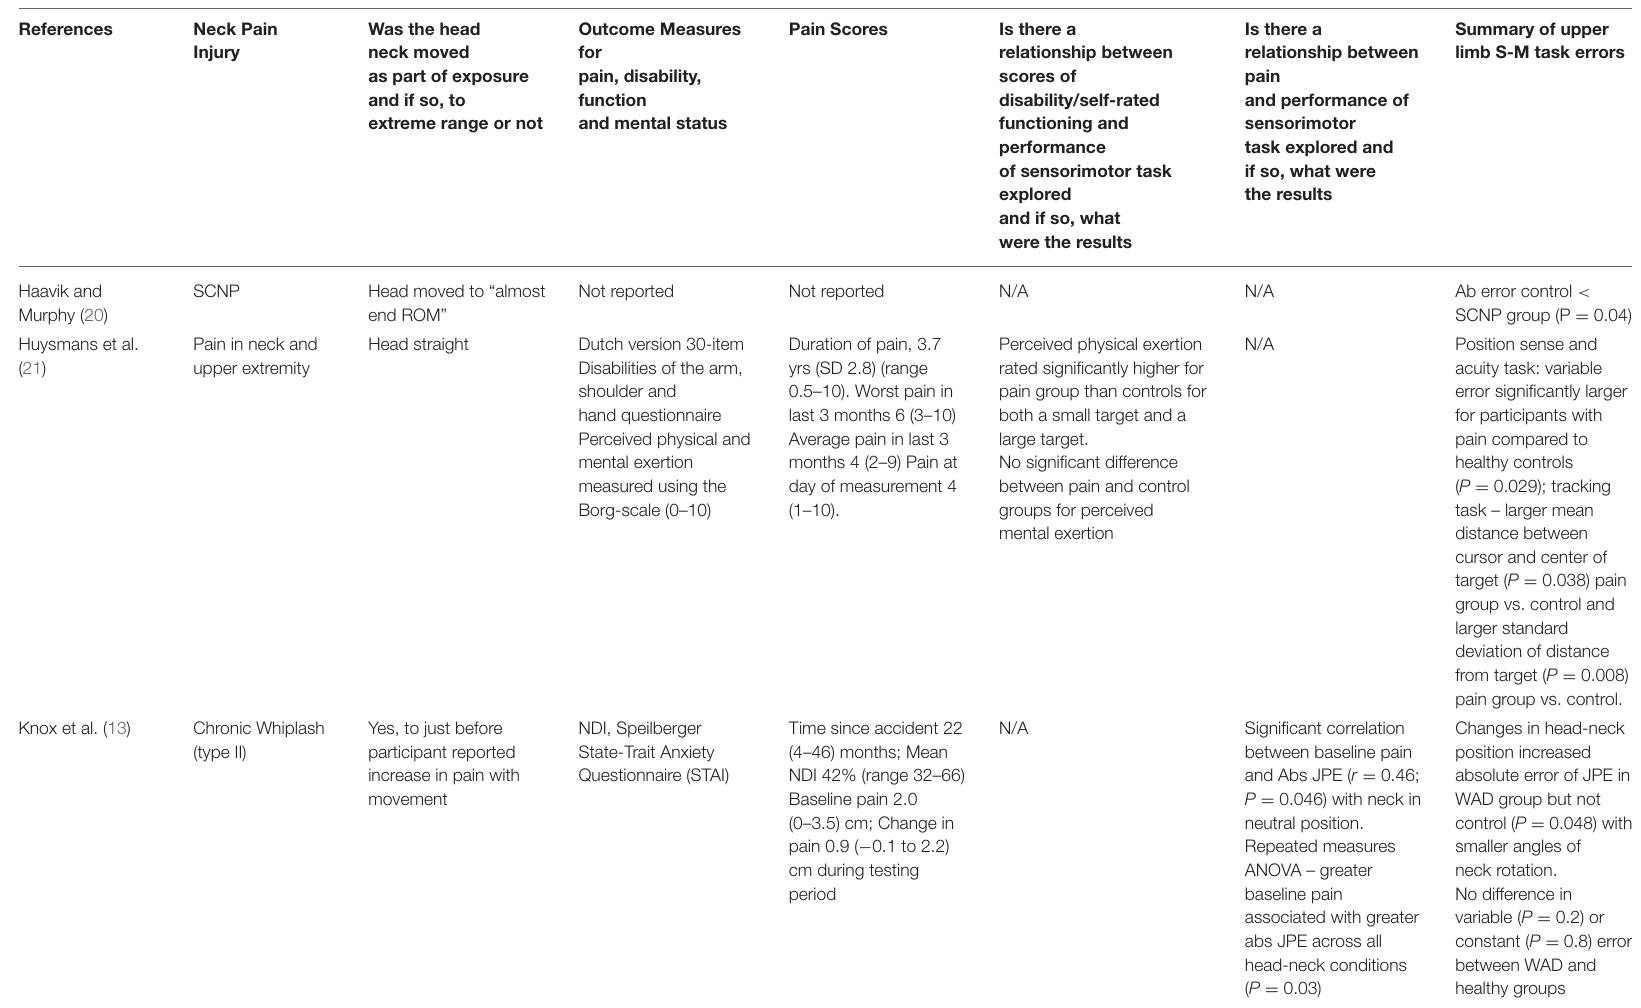
TABLE 5 | Association between pain and self-rated function and upper limb sensorimotor task